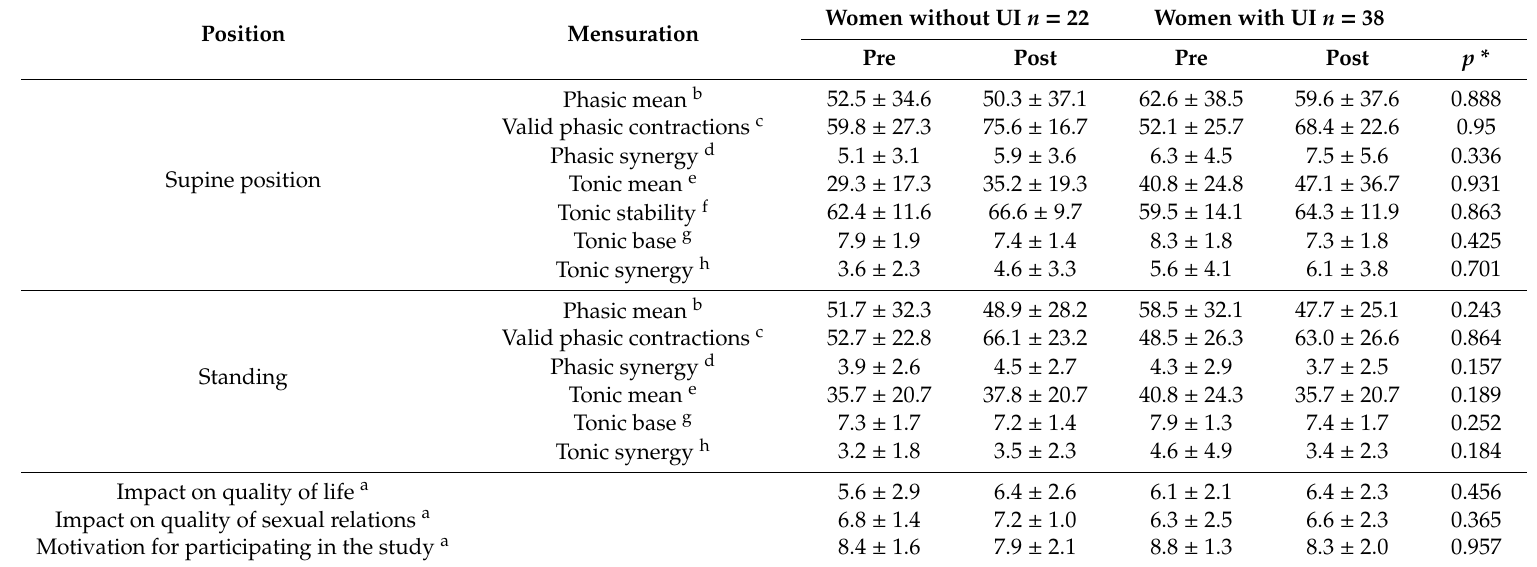
Table 2. Comparison between the initial and final assessment via the ANOVA